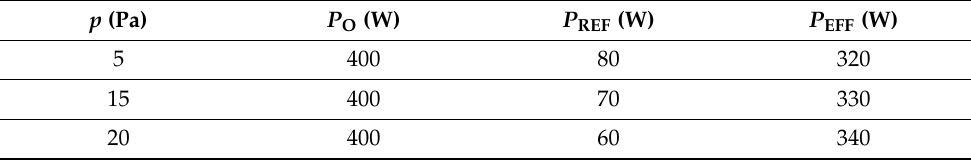
Table 2. Overview of treatment powers and pressures during plasma treatment of bean seeds. P O , output power; P REF , reflected power; P EFF effective power.